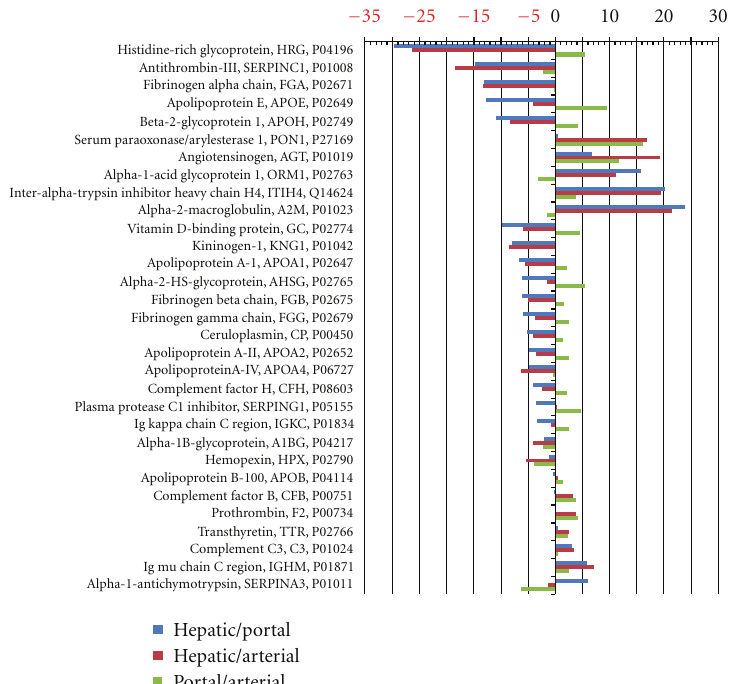
Figure 3: All quantified proteins and percent changes. The Mascot quantification results from all patients and MS repeat runs were averaged and the percent change values were calculated. All changes above 10% were considered significant. The proteins are represented as UniProtKB protein and gene names and